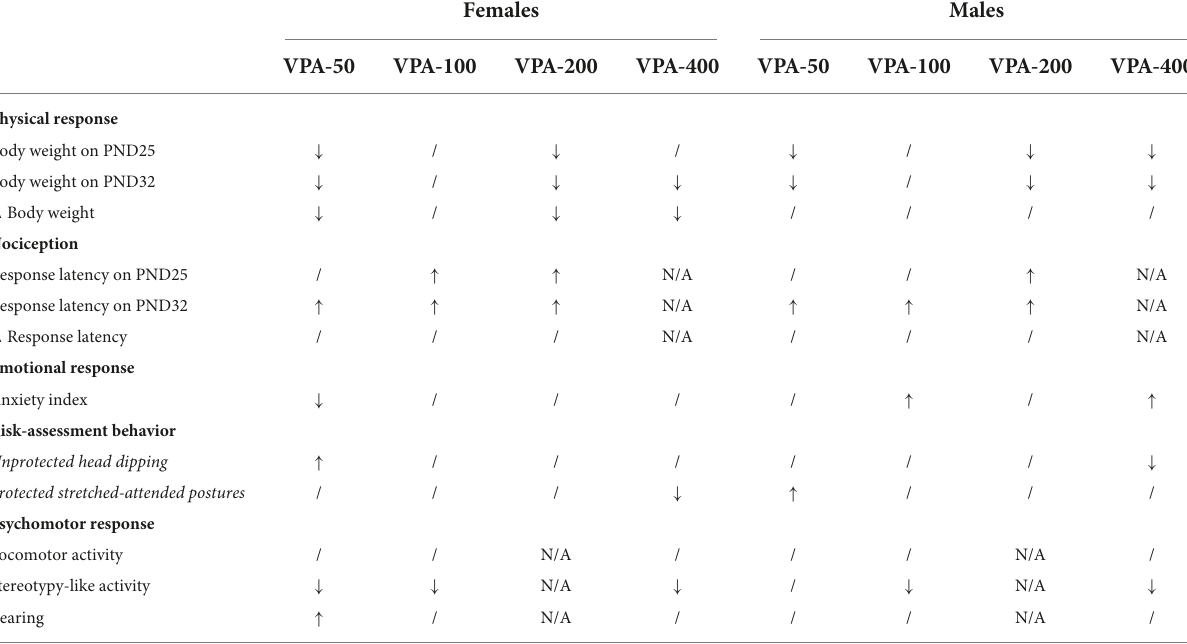
TABLE 2 Summary of physical, nociceptive, emotional, and psychomotor responses of adolescent female and male mice exposed to VPA at doses of 50 mg/kg (VPA-50), 100 mg/kg (VPA-100), 200 mg/kg (VPA-200), and 400 mg/kg